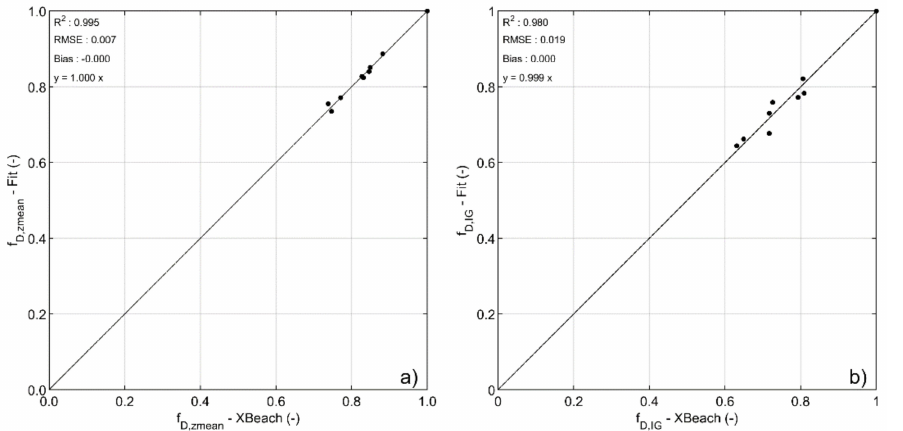
Figure 15. Comparison of simulated and computed directional spreading reduction factors f D for set-up ( a ) and infragravity run-up ( b ). Dashed line indicates unity (y =